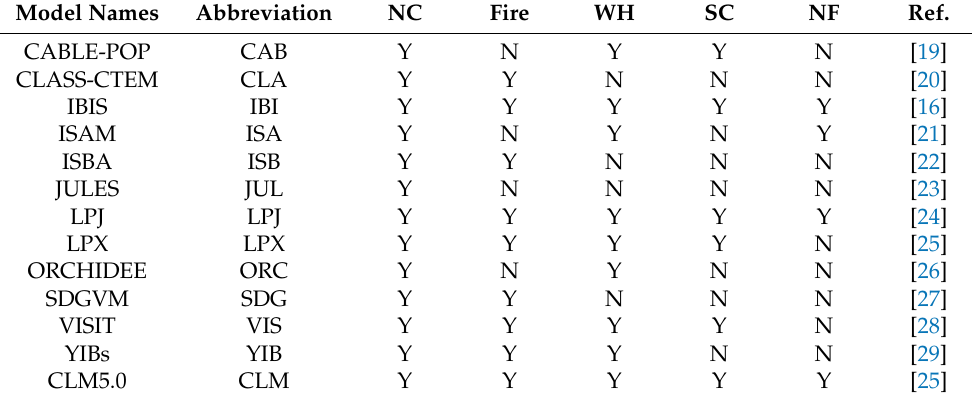
Table 1. The 13 TRENDY models used in this study.